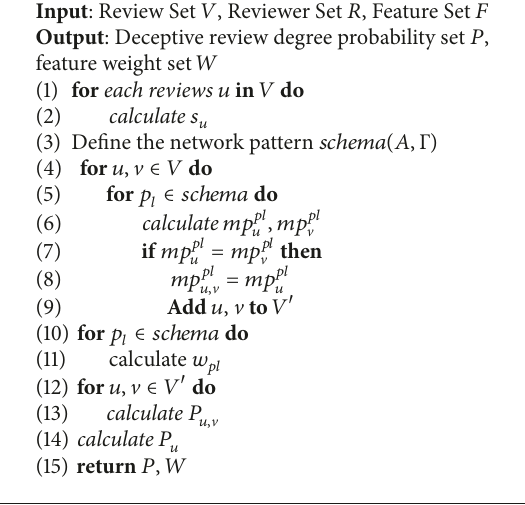
Table 4: Experimental environment table.